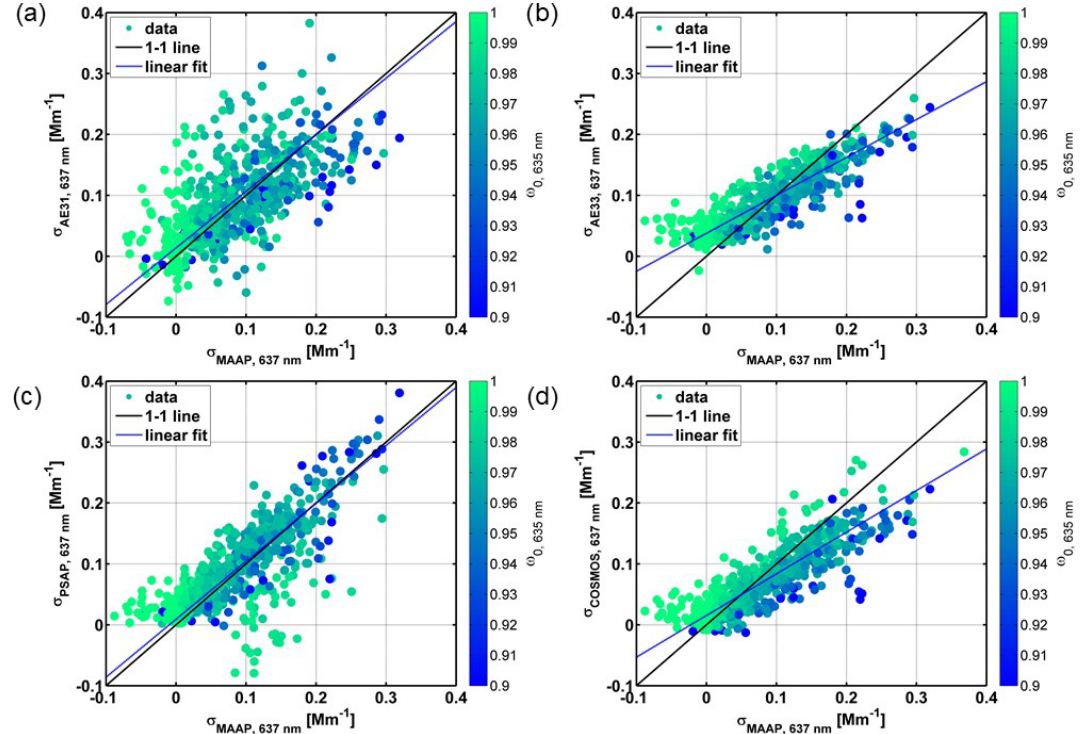
Figure 4. One-hour averaged absorption coefficient measured by MAAP ( x axis) and by (a) AE31, (b) AE33, (c) PSAP, and (d) COSMOS colored by 1h averaged ω 0 , 635nm . The solid lines are bivariate fits to the data, and the dashed lines are the 1 : 1 values. The corresponding correlation coefficients, their standard errors, and the R 2 statistics are presented in Table